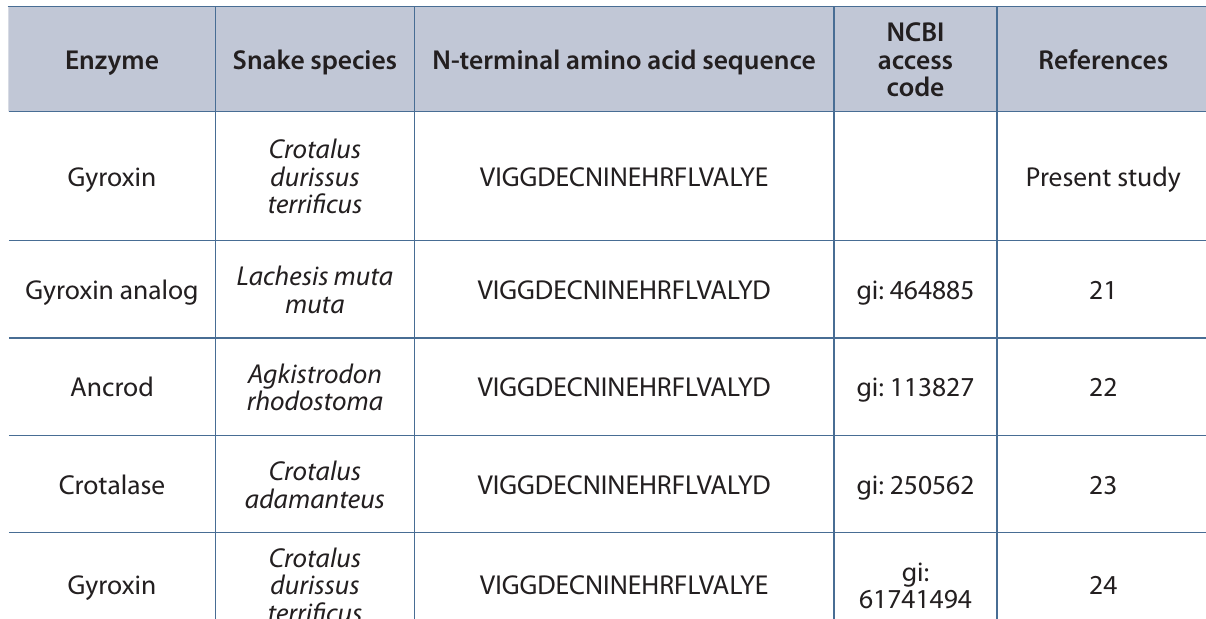
Table 1. Comparison of the N-terminal amino acid sequence of gyroxin with other snake venom serine